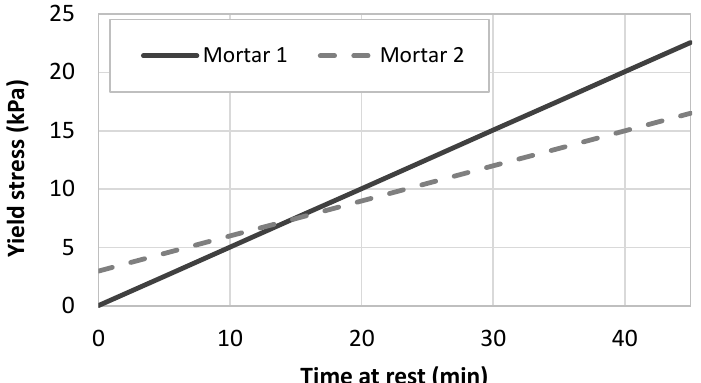
Figure 4. Static yield stress evolution of mortars representative of a fluid accelerated one (Mortar 1) and a firm one used in the infinite brick method (Mortar 2).